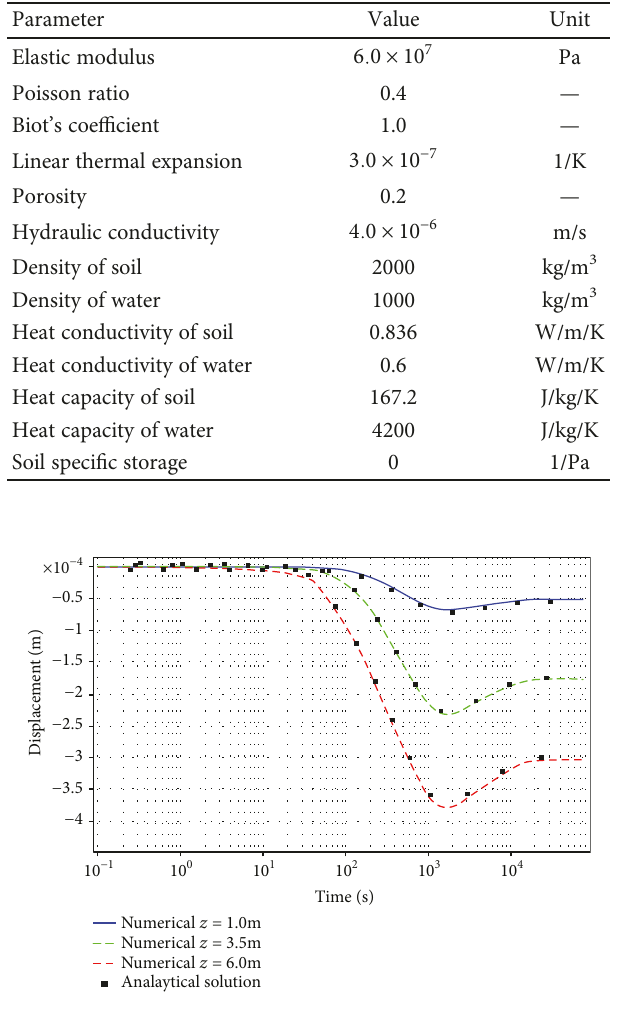
Figure 5: Displacement evolution with time at di ff erent positions within the soil column.